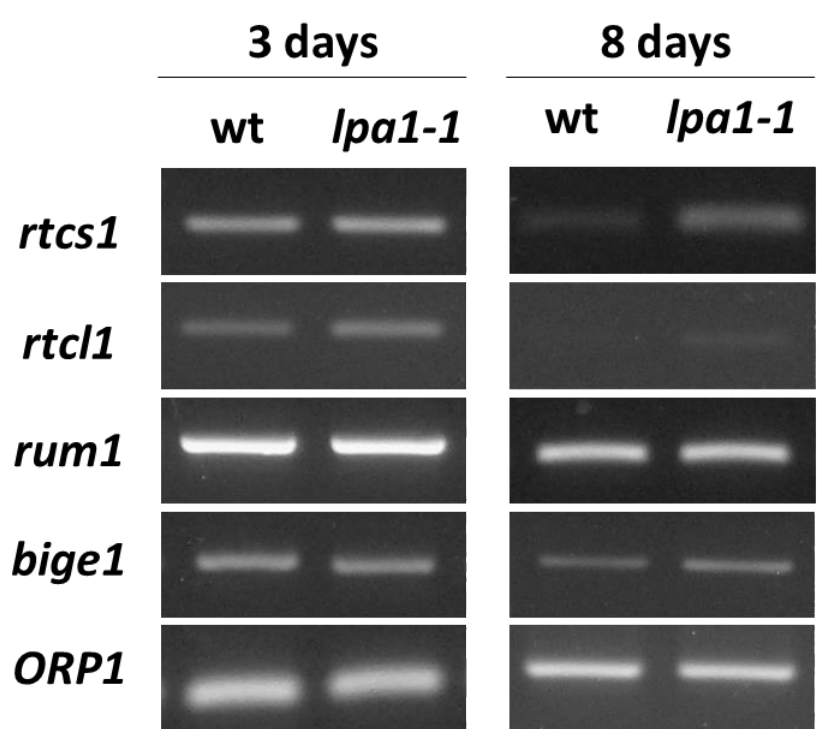
Figure 5. rtcs1 , rtcl1 , rum1 and bige1 gene expression levels on 3- and 8-day roots of wild-type and lpa1-1 . Orp1 gene was used as control.